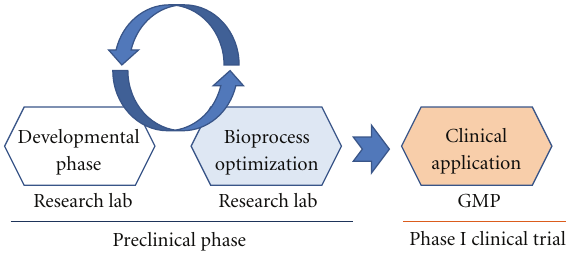
Figure 3: Dynamic bioprocess optimization. This dynamic interac- tion between the optimization and the preclinical phase allows for easy transition of a cell product into the